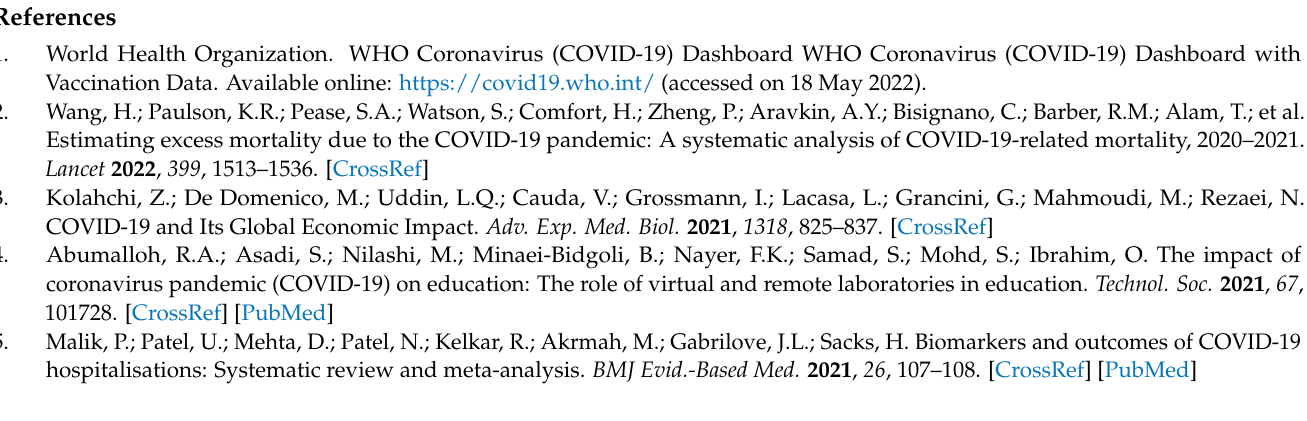
Table S2: Search Strategy; Table S3: Newcastle—Ottawa Quality assessment scale for included studies; Figure S1: Subgroup analysis according to countries of the association between FAR and severity of COVID-19 patients; Figure S2: Sensitivity analysis of the association between FAR and severity of COVID-19 patients; Figure S3: Subgroup analysis according to countries of the association between FAR and mortality of COVID-19 patients; Figure S4: Sensitivity analysis of the association between FAR and mortality of COVID-19